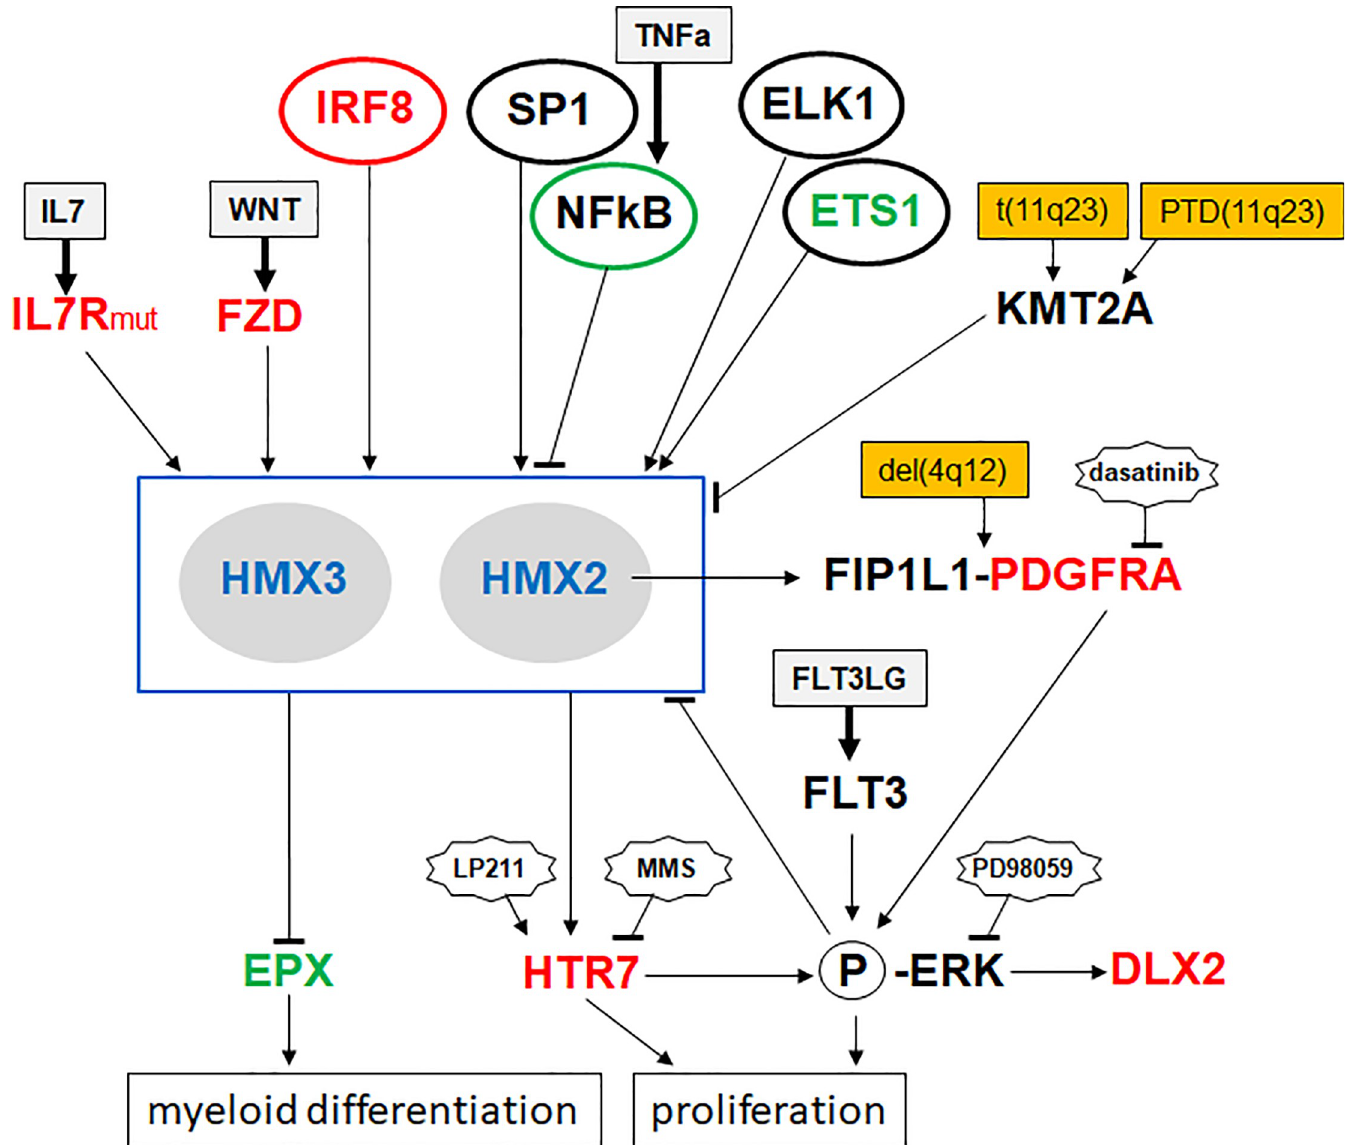
Fig 8. Gene regulatory network for HMX2 and HMX3 in AML. This diagram summarizes the results of this study, showing a gene regulatory network. HMX2 and HMX3 are located centrally, activating and repressing factors and pathways are indicated above, and the target genes EPX and HTR7 below. Deregulation of EPX and HTR7 indicates aberrant effects for differentiation and proliferation. Genomic rearrangements targeting KMT2A or PDGFRA are indicated.